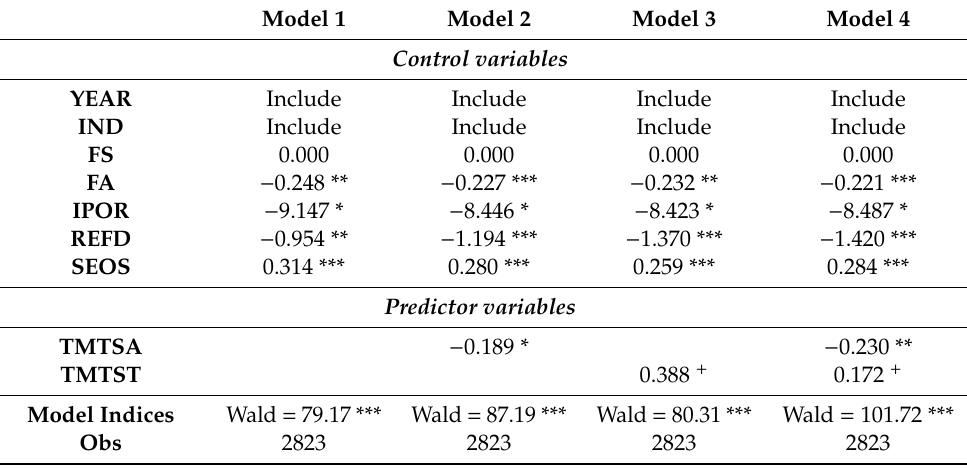
Table 4. Results of regression analyses on mergers and acquisitions (M&A) propensity.